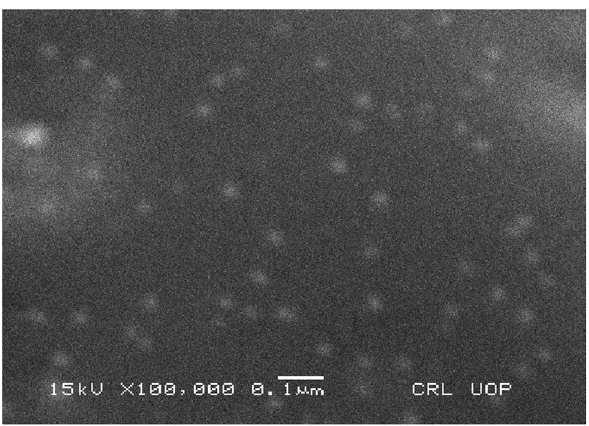
Figure 10: SEM image of the AgNPs after bio - reduction by T. govanianum .